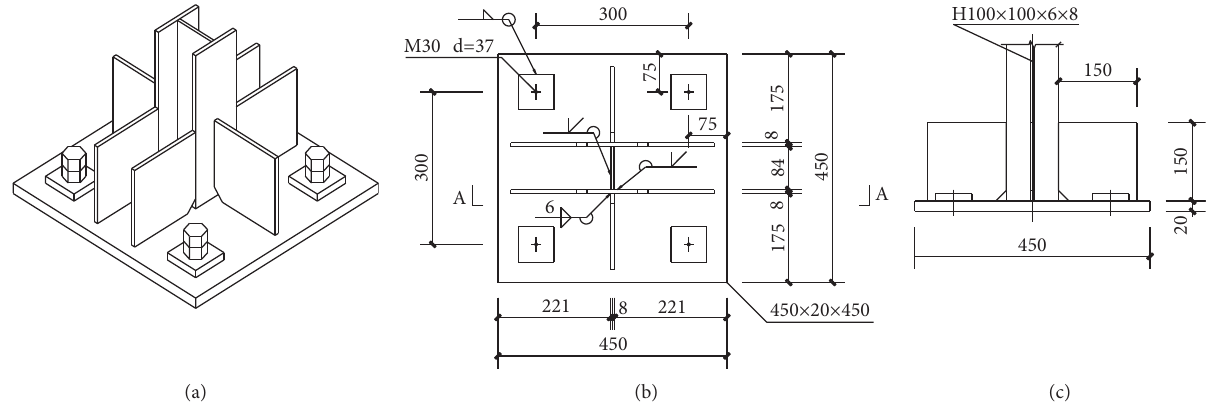
Figure 3: Detailed connections at the bottom of columns (mm). (a) 3D. (b) Plane. (c) Section A-A.